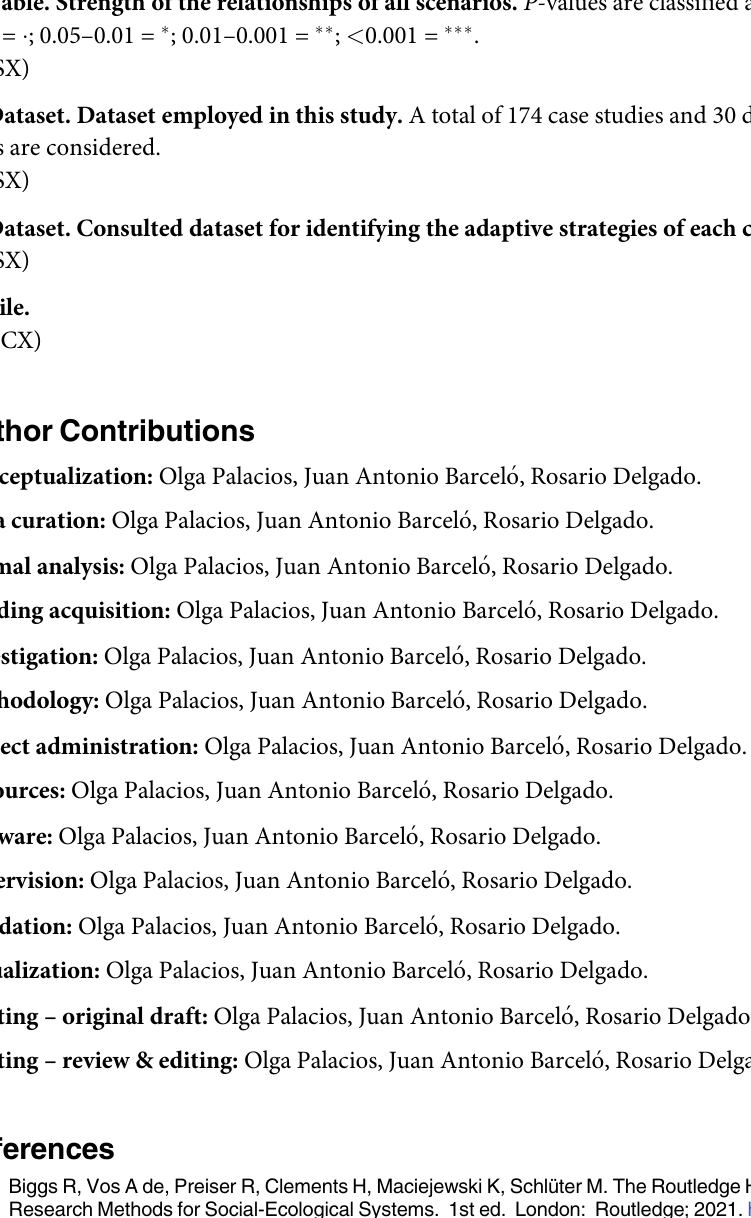
Empty cells correspond to statistically non-significant probabilities. “Model 1 > Model 2” means that the alternative hypothesis (which is accepted if the p -value is < 0.05) is that the mean accuracy is greater for the Model 1 than for the Model 2. P -values are classified as fol- lows: 0.05–0.01 = � ; 0.01–0.001 = �� ; < 0.001 = ��� . In Model B, significant relationships among inputs are not represented (only among outputs) to avoid noise from variables that we do not predict and are expectable (i.e., the relationship among environmental characteristics). S5 Table. Strength of the relationships of all scenarios. P -values are classified as follows: 0.1– 0.05 = � ; 0.05–0.01 = � ; 0.01–0.001 = �� ; < 0.001 = ��� . S1 Dataset. Dataset employed in this study. A total of 174 case studies and 30 different vari- ables are considered. S2 Dataset. Consulted dataset for identifying the adaptive strategies of each case